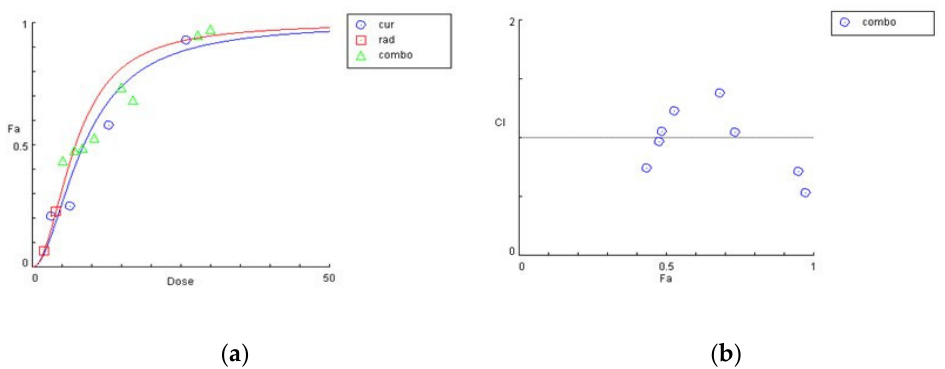
Figure 5. Graphical presentations obtained from the CompuSyn Report for the curcumin and radiation combination in T98 cells. ( a ) Dose–effect curve; ( b ) combination index plot. DRI >1 and <1 indicate a favorable and not favorable dose–reduction, respectively, and DRI = 1 indicates no dose-reduction. As seen in Figure 6, in both U87 (a) and T98 (b) cell lines, most combinations of curcumin and radiation show a favorable dose–reduction (DRI > 1).